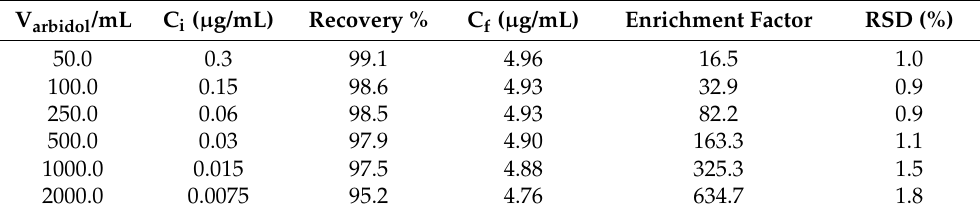
Experimental conditions: m immobilized-HBA = 100 mg, T = 20 ◦ C, pH =